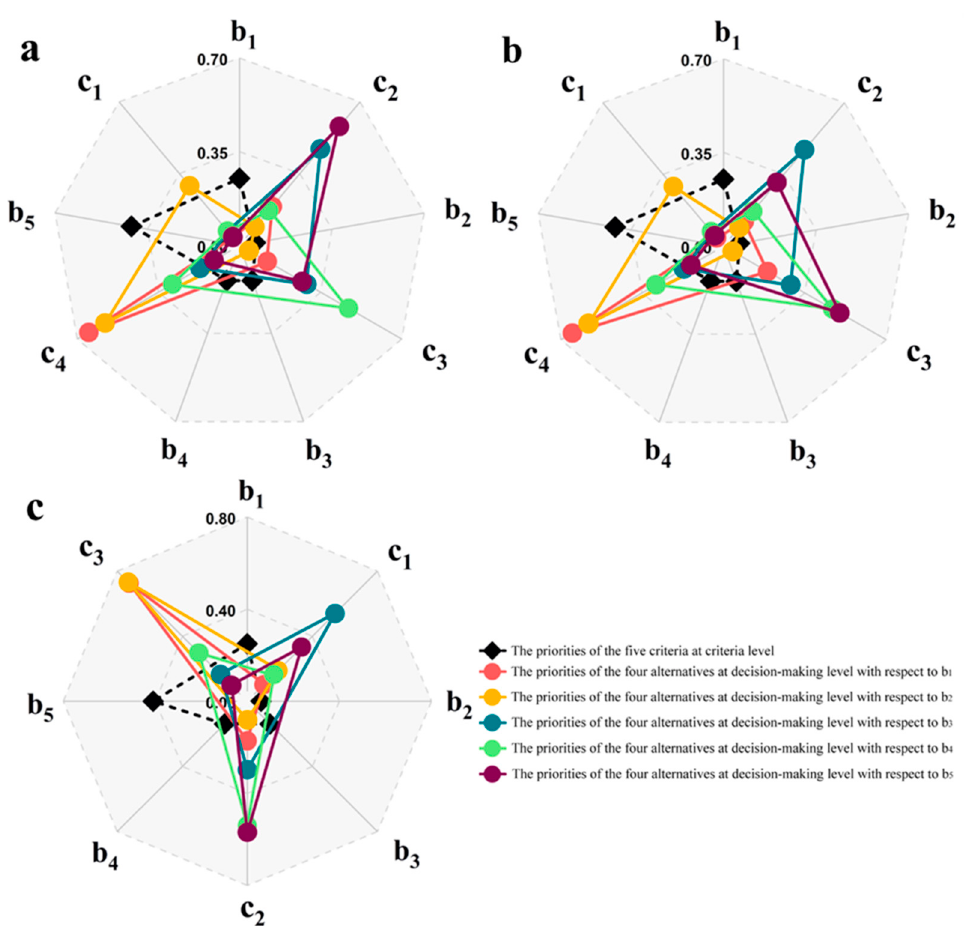
Figure 9. The local priorities of elements at criteria and decision-making levels: ( a ) COD; ( b ) NH 3 -N; and ( c ) TP.